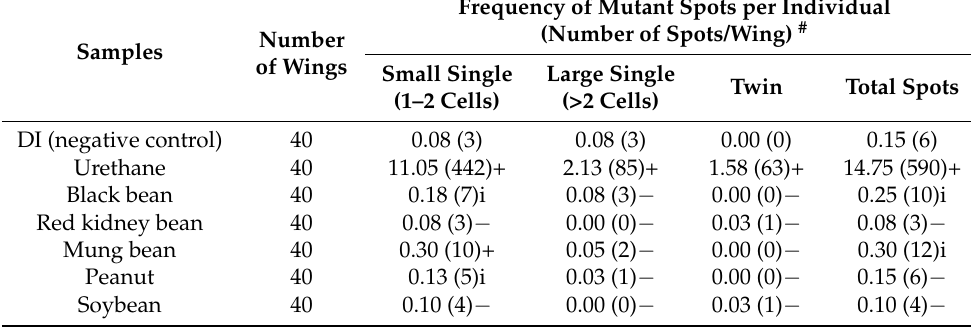
Table 2. Frequency of mutant spots observed in trans-heterozygous, high bioactivation (HB) flies treated with DI, urethane or bean milks in the pre-feeding